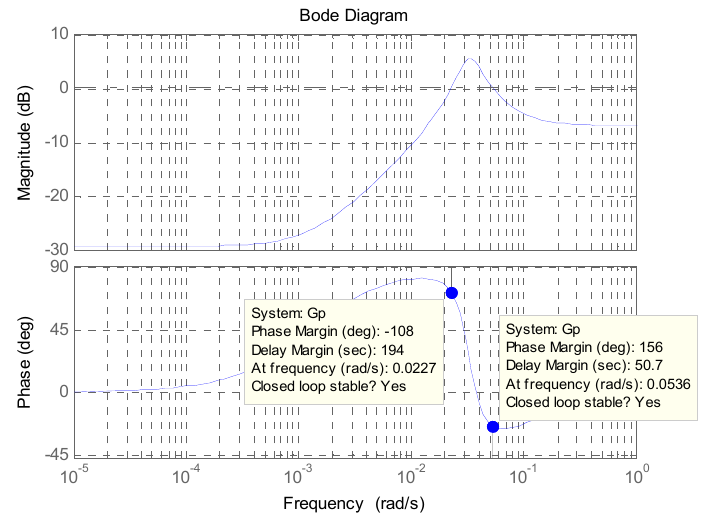
Figure 7. Bode diagram of the system transfer function